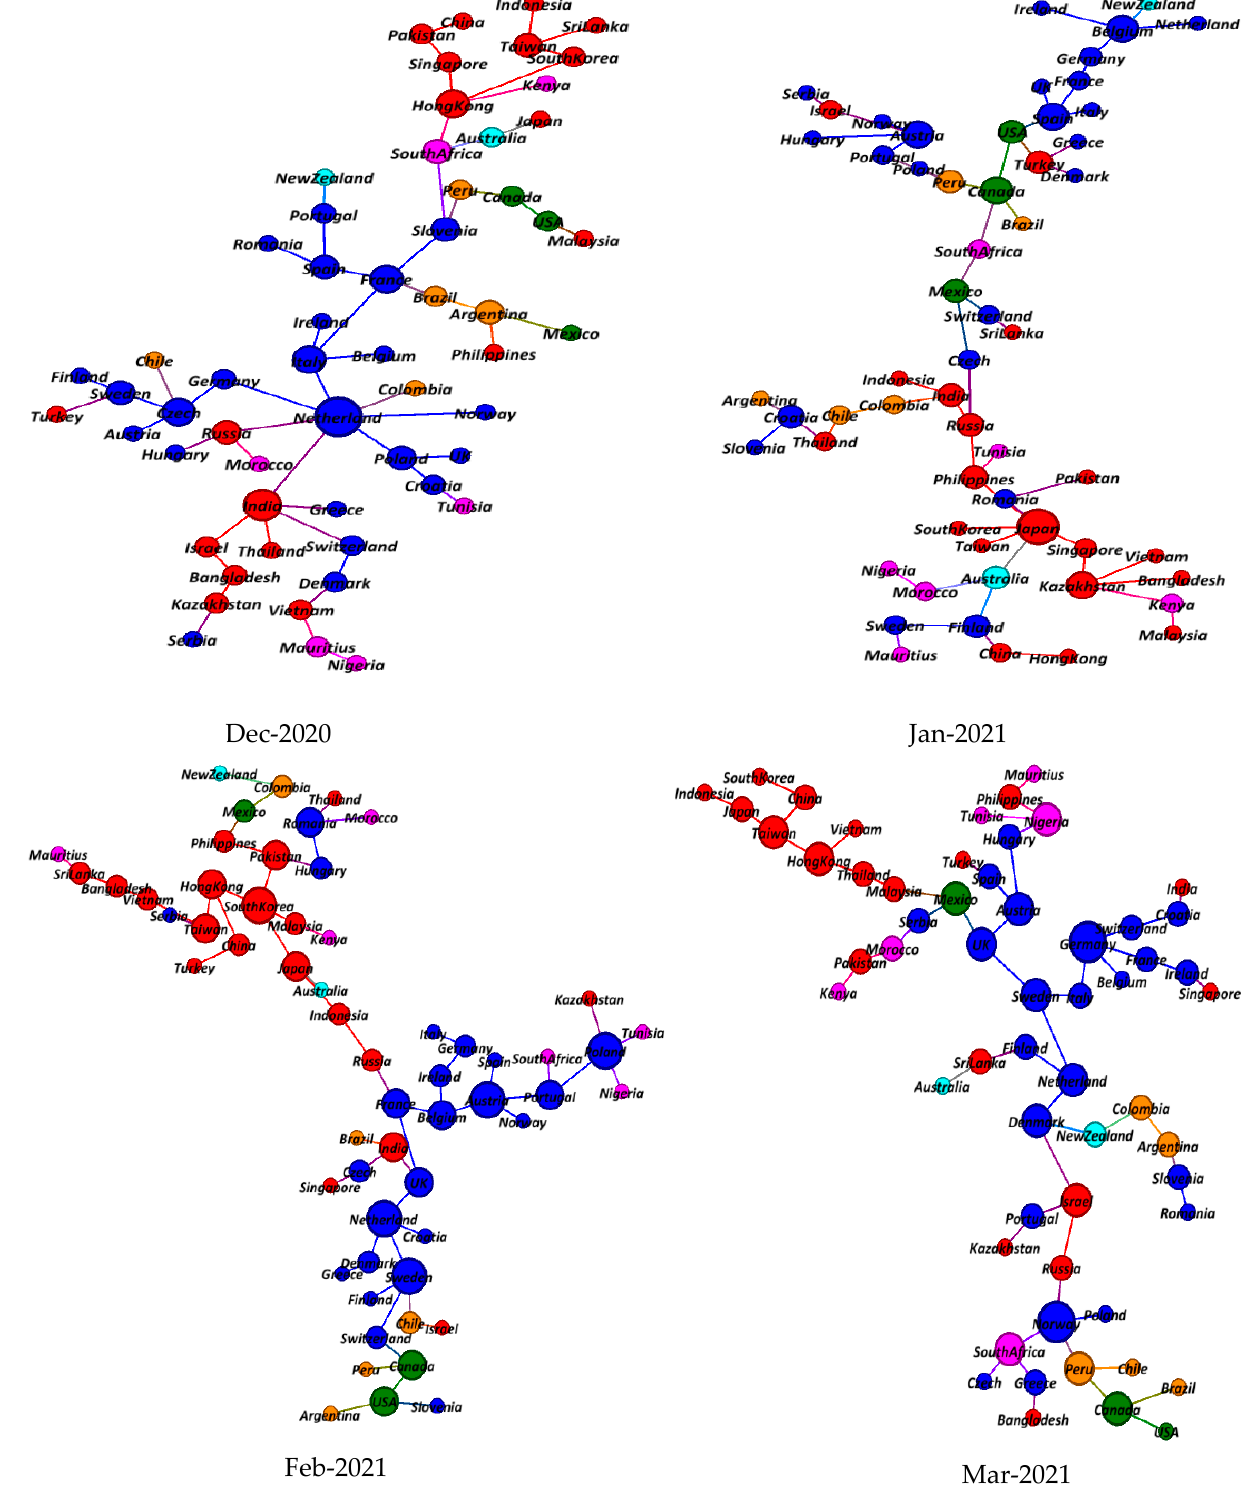
Figure 5. Comparison of dynamic MSTs of the world stock market network from December 2020 to March 2021.